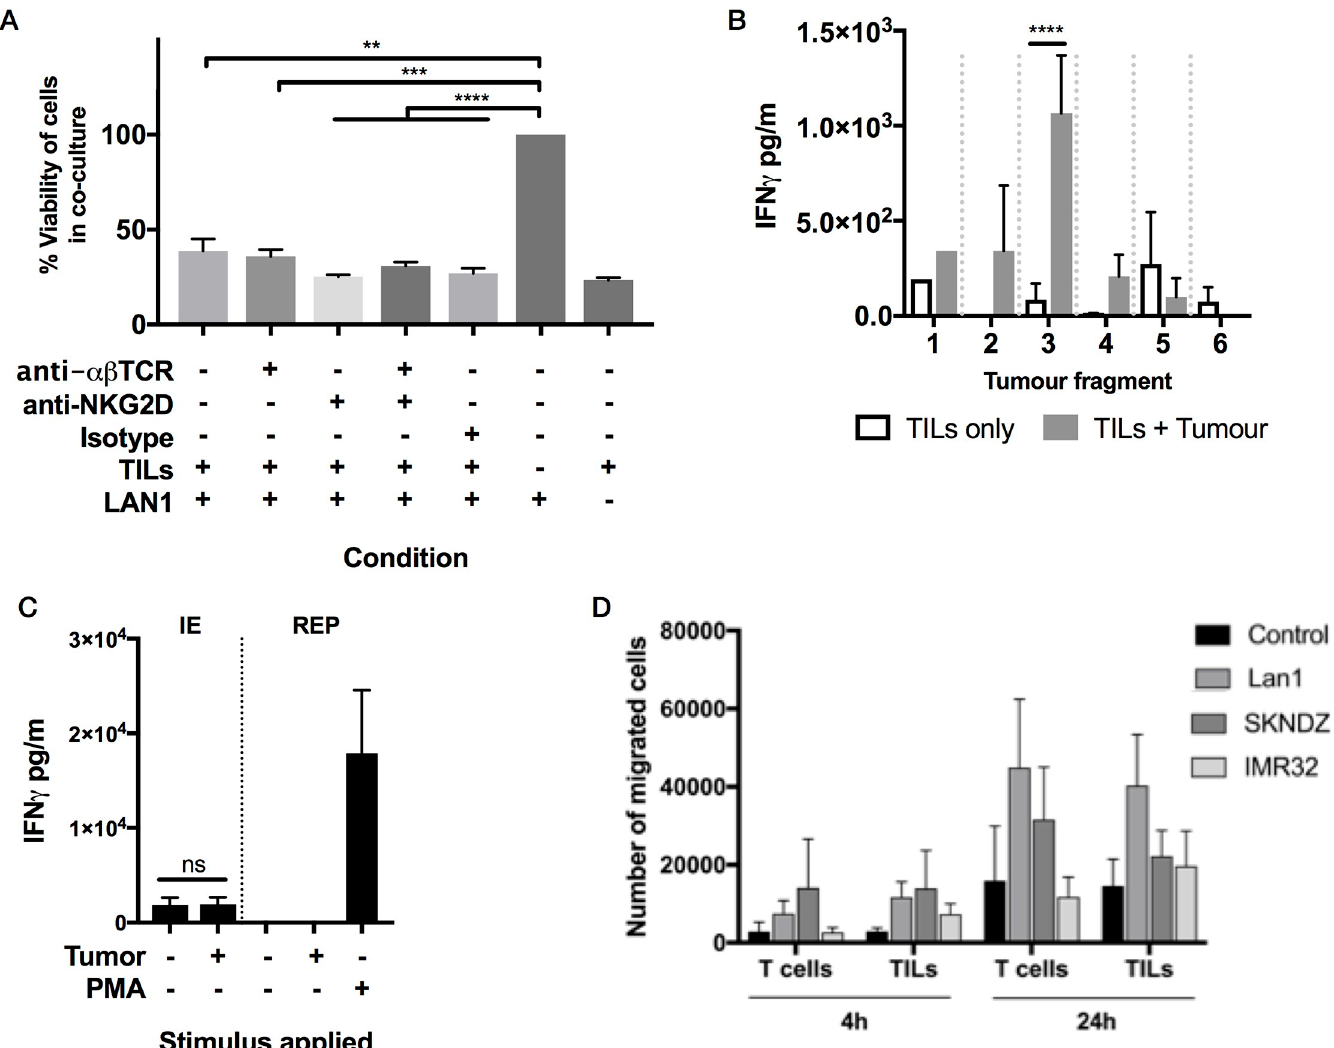
Fig 5. Functional potential of neuroblastoma expanded TILs. (A) LAN1 neuroblastoma cells were co-cultured overnight with TILs and cell viability was assessed using an MTT assay. Presence of TILs significantly reduced viability of LAN1 cells in a manner which could not be blocked using TCR or Natural Killer Group 2D (NKG2D) blocking antibodies. (B) Example of a donor whose TILs were able to mount an IFN γ response against 1/6 autologous tumor fragments. In this case, IFN γ production by TILs was significantly increased in the presence of a 1-2mm tumor fragment (p = < 0.0001 by paired 2-way ANOVA with Sidak’s correction). Error bars are ± SEM of technical replicates (n = 1–3) for each tumor fragment/TIL co-culture. (C) IFN γ secreted by TILs in the absence or presence of autologous neuroblastoma tumors after initial expansion (n = 24) or after REP (n = 6). Stimulation with PMA is used as a positive control to demonstrate the capacity to mount an IFN γ response. (D) Migration of T-cells and TILs towards neuroblastoma cell lines (Lan1, SKNDZ and IMR32) at two different time points (4 and 24 h). T-cells or TILs were placed in the top chamber of a trans-well and target cells were placed in the bottom. At 4h, TILs: n = 3 and T cells: n = 2. At 24h, TILs: n = 8 and T cells: n = 3. Data represented as mean ±